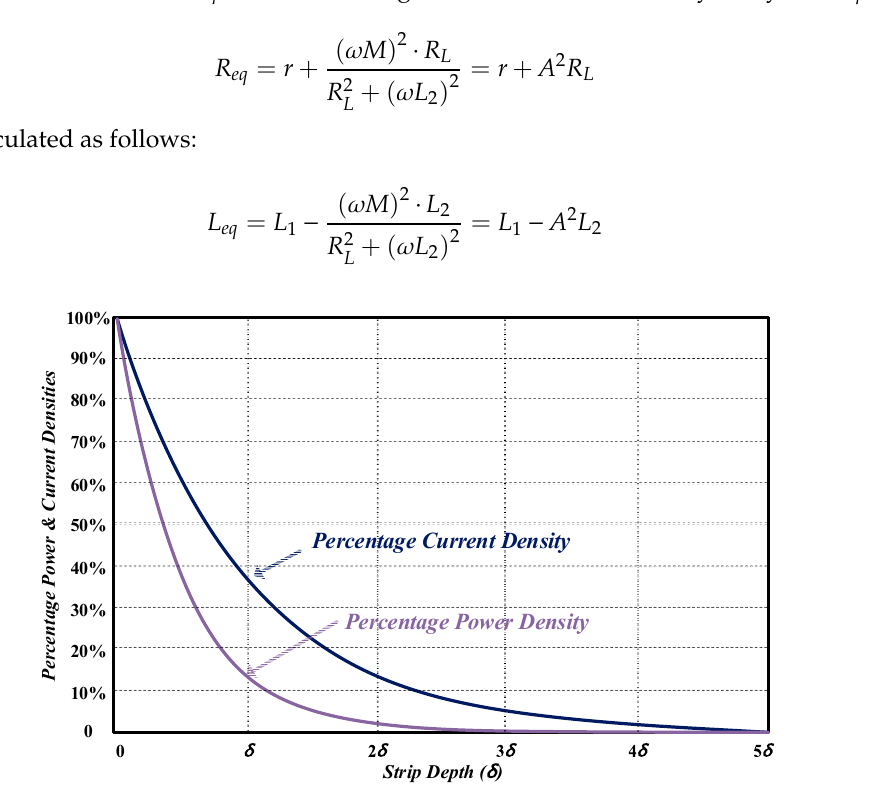
Figure 8. Parameter values of the Ti load based on frequency variation.